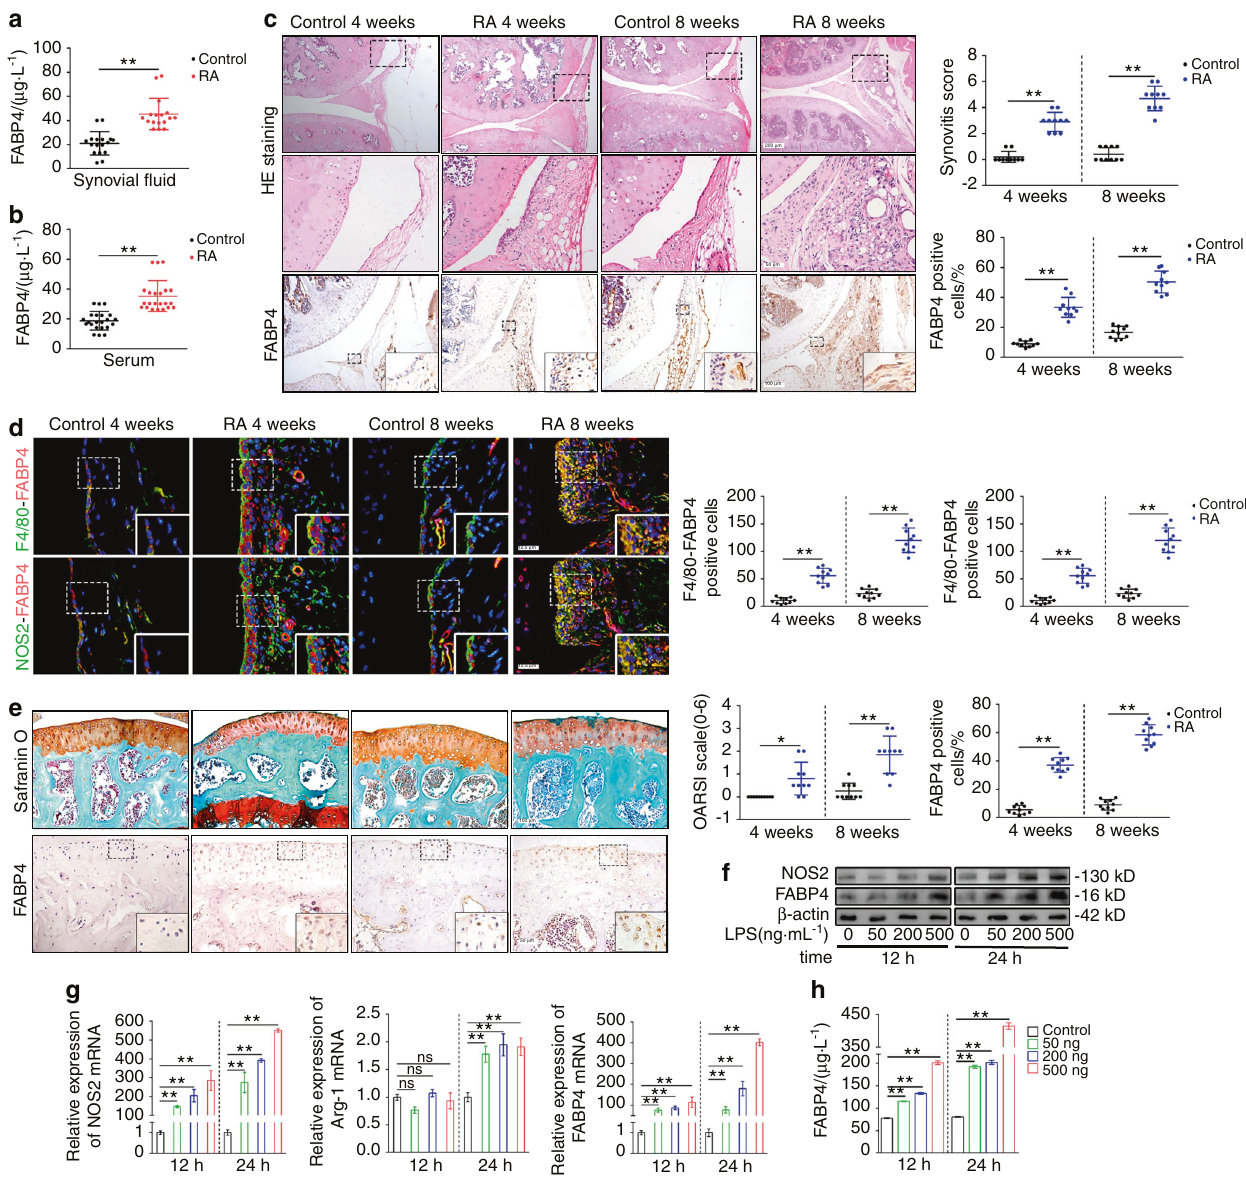
Fig. 1 The expression of FABP4 in the RA mouse model, BMDMs and RA patients. a , b FABP4 concentrations in the synovial fl uid ( a ) and serum ( b ) of controls and RA patients ( n = 8 per group) were assessed by ELISA. C Representative images and quanti fi cation of HE staining and FABP4 immunohistochemical staining in the synovium of control and C57BL/6 J mice at 4 and 8 weeks after AIA modeling ( n = 10 per group). Scale bars: 50 μ m, 100 μ m and 200 μ m. d Representative images and quantitative analysis of coimmunostaining of FABP4 with F4/80 or NOS2 in the synovium of control and C57BL/6 J mice at 4 and 8 weeks after AIA modeling ( n = 10 per group). Scale bars: 12.5 μ m. e Representative images and quanti fi cation of safranin O and fast green staining and FABP4 immunohistochemical staining in knee cartilage from controls and C57BL/ 6 J mice at 4 and 8 weeks after AIA modeling ( n = 10 per group). Scale bars: 50 μ m and 100 μ m. f Western blot showing FABP4 and NOS2 in BMDMs stimulated with 50, 200, or 500 ng·mL − 1 LPS for 12 h or 24 h. g Quantitative PCR analysis of NOS2, Arg-1, and FABP4 mRNA expression in BMDMs ( n = 3 per group). h FABP4 concentrations in the supernatant of BMDMs stimulated with 50, 200, or 500 ng·mL − 1 LPS for 12 h or 24 h ( n = 3 per group) were assessed by ELISA. Student ’ s t -test or one-way analysis of variance (ANOVA) and Tukey ’ s multiple comparison demonstrate that FABP4, the key effector cytokine in M1- macrophages regulate the proliferation of HUVECs and FLSs polarized macrophage supernatant, promotes HUVEC and FLS partially through the MAPK pathway. Compared to cells treated migration and invasion. with the control, HUVECs and FLSs treated with rhFABP4 or M1- polarized macrophage supernatant exhibited obvious migration and invasion, as indicated by the increased numbers of cells (Fig. 2g) and the elevated percentage of wound healing (Fig. S3G, H). BMS309403 signi fi cantly inhibited the migration and invasion of HUVECs and FLSs induced by rhFABP4 or M1-polarized macro- phage supernatant (Fig. 2g and Fig. S3G, H). These data